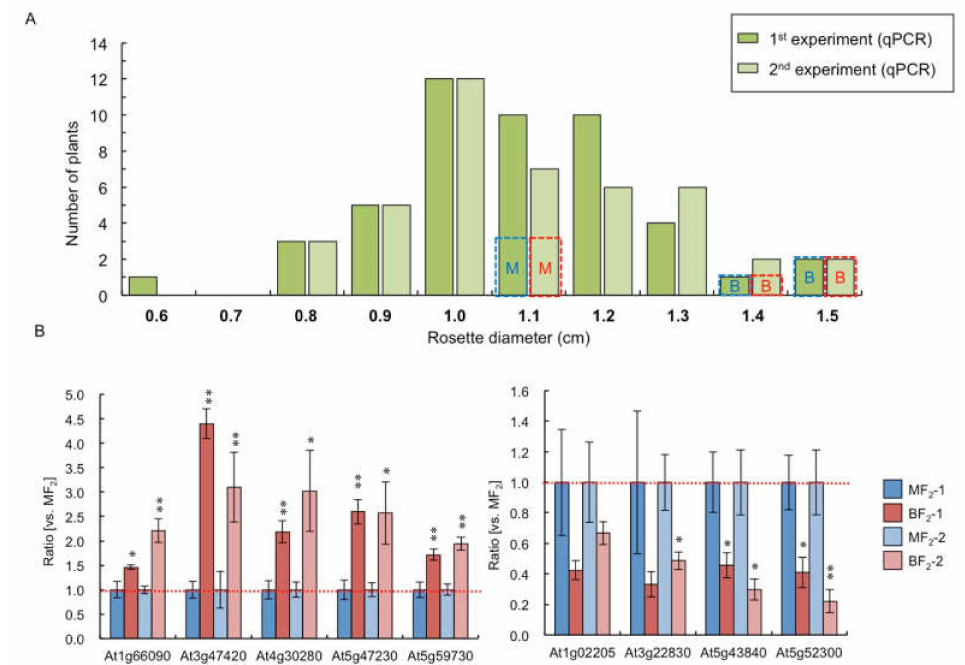
Figure 4. Comparison of the gene expression level between big- and medium-sized F 2 plants. ( A ) Distribution of rosette diameter at 14 DAS of F 2 plants. Blue and red dotted lines represent the plant size used for qPCR. ( B ) qPCR using genes that showed B1&B2 > M1&M2 (left panel) and B1&B2 < M1&M2 expression (right panel). The ratio of the expression levels compared with medium-sized F plants in big-sized F 2 plants is shown. Data presented are the average and standard error (s.e.) from three biological and experimental replicates. * p < 0.05, ** p < 0.01 (Student’s t